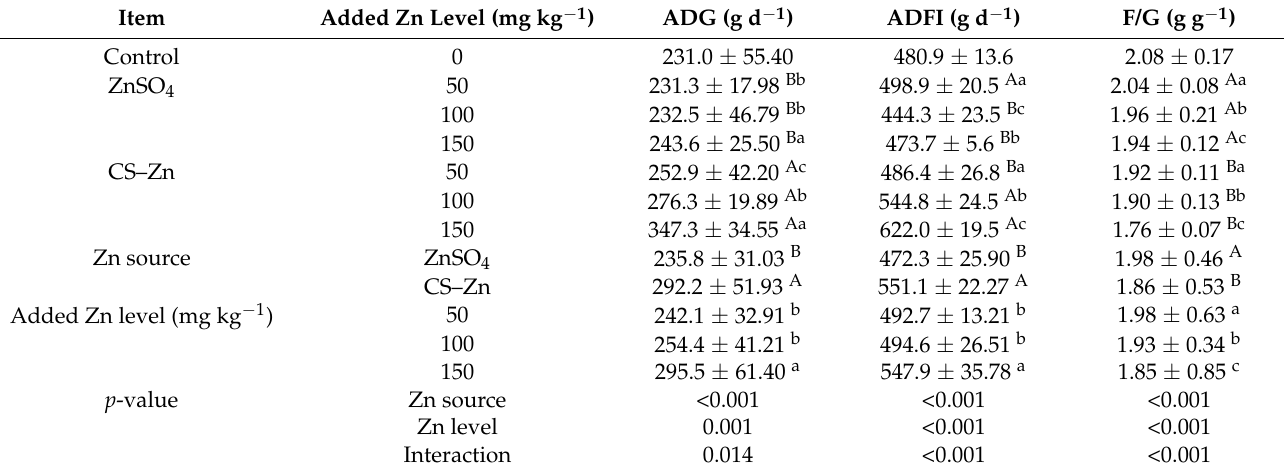
Table 2. Effects of dietary Zn source and level on the growth performance of weaned